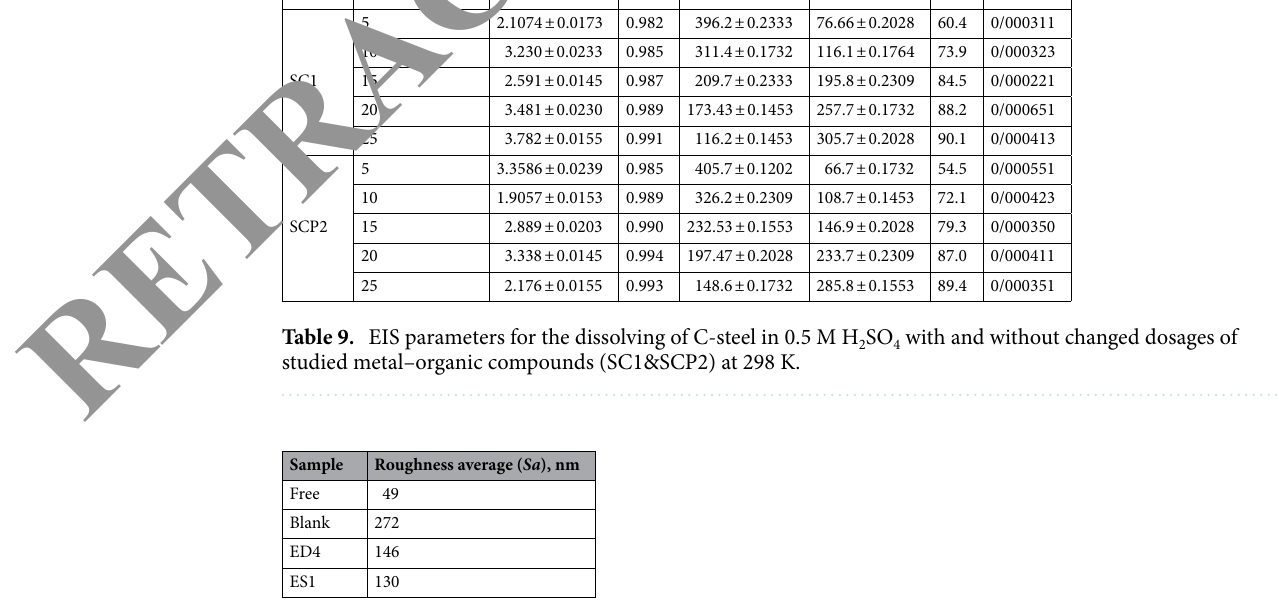
Figure 11. Equivalent circuit model used to fit experimental EIS.